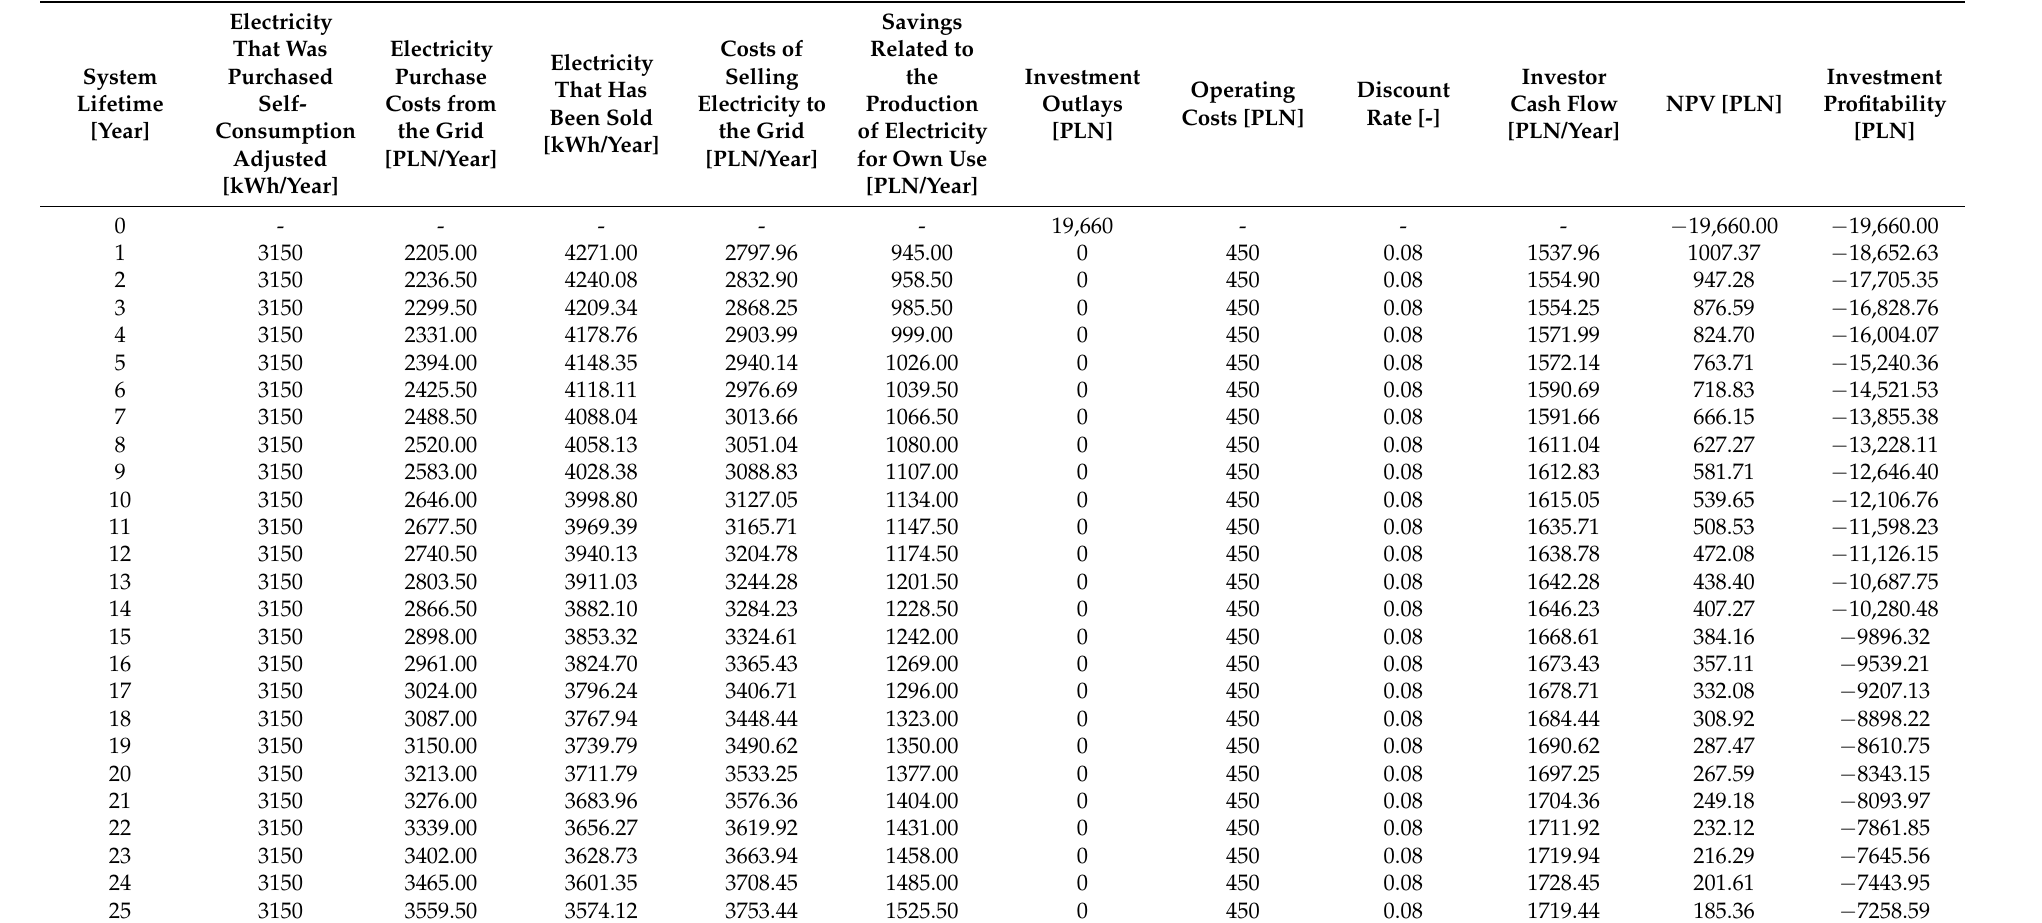
Table A3. NPV results of the PV installation for the net-billing system based on hourly prices, at a 30% self-consumption